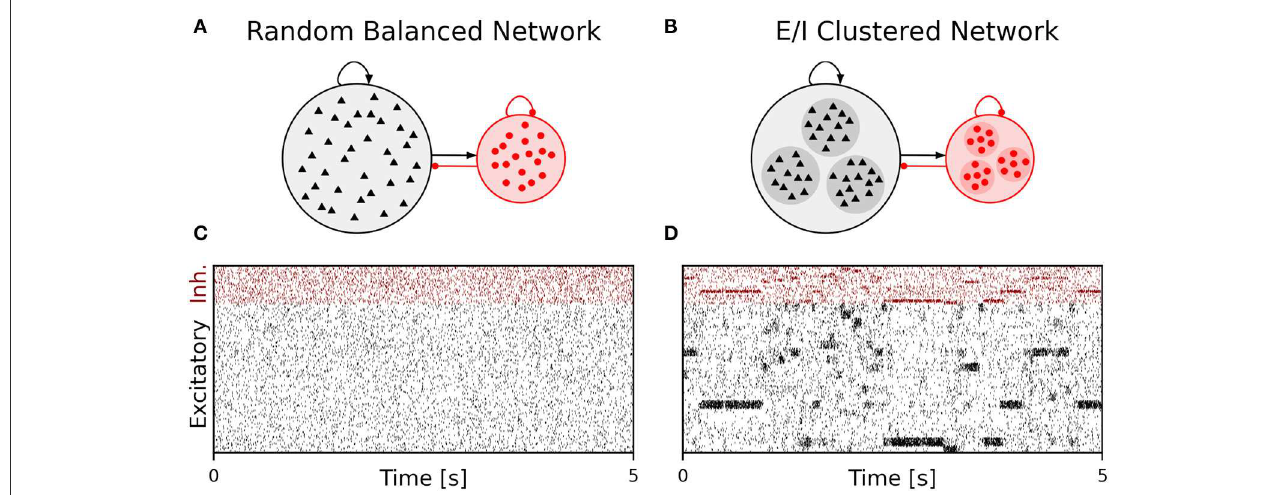
FIGURE1 Metastable network activity emerges by introducing excitatory-inhibitory clusters in the random balanced network. (A) Sketch of RBN architecture with one excitatory neuron pool (gray shaded circle, 80% of all neurons) and one inhibitory neuron pool (red shaded circle, 20% of all neurons). Excitatory neurons (black triangles) and inhibitory neurons (red circles) make random connections within and across pools, respectively. The respective connection strengths are tuned such that for each neuron, on average, the total synaptic input current balances excitatory and inhibitory input currents. (B) Sketch of excitatory-inhibitory (E/I) cluster topology. Both, excitatory and inhibitory neuron pools are tiled into clusters (small shaded circles) of strongly interconnected neurons (indicated by darker shading). In addition, each excitatory cluster is strongly and reciprocally connected to one corresponding inhibitory cluster such that the balance of excitatory and inhibitory synaptic input is retained for all neurons. In our network definition, a single parameter J E + determines the cluster strength in terms of synaptic weights and allows to move from the RBN ( J E + = 1) to increasingly strong clusters by increasing J E + > 1. The model uses exponential leaky Integrate-and-Fire (I&F) neurons, and all neurons receive weak constant input current. (C, D) Raster plot of excitatory (black) and inhibitory (red) spiking activity in a network of N = 25,000 neurons during 5s of spontaneous activity after an initial warm-up time of 1 s was discarded. Shown are 8% of the total neuron population. The spike raster plots are generated from GeNN simulations. (C) The RBN ( J E + = 1.0, I thE = 2.6, I thI = 1.9) exhibits irregular spiking of excitatory and inhibitory neurons with constant firing rates that are similar for all excitatory and inhibitory neurons, respectively. (D) The E/I clustered network ( J E + = 2.75, I thE = 1.6, I thI = 0.9) shows a metastable behavior, where different individual E/I clusters